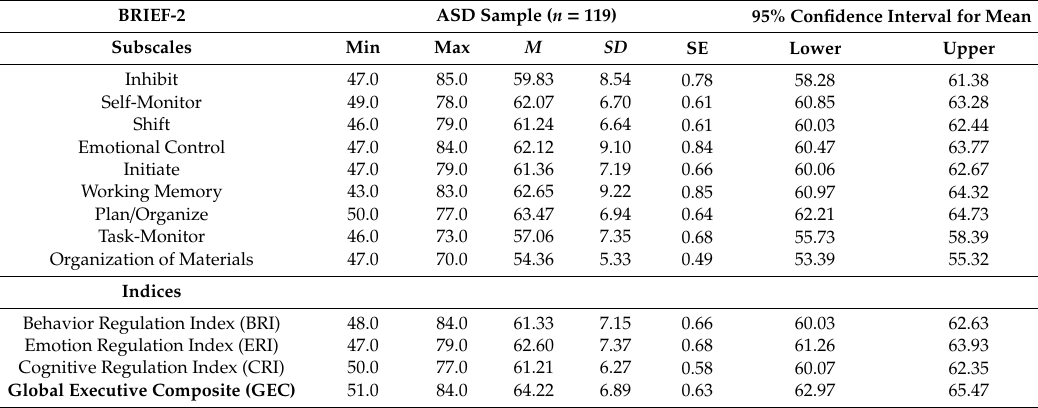
Table 3. Descriptive Statistics Concerning the Executive Functioning Domains Across the Scales, Indices and Global Executive Composite (GEC) of the